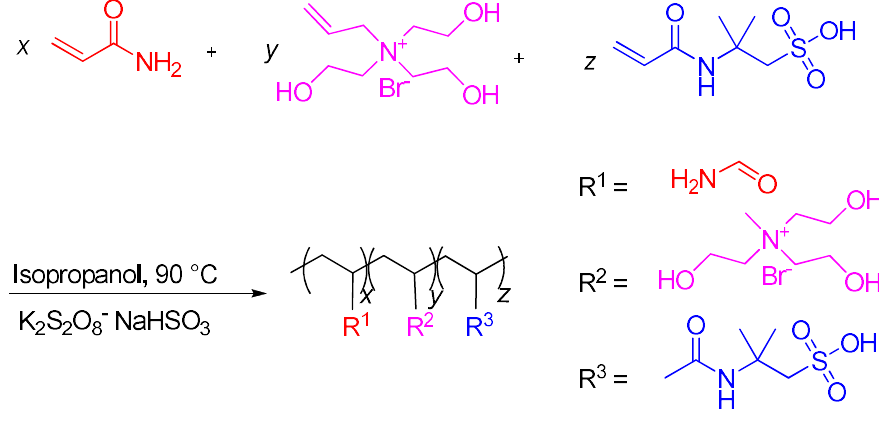
Figure 2. Synthesis route of SX-1.